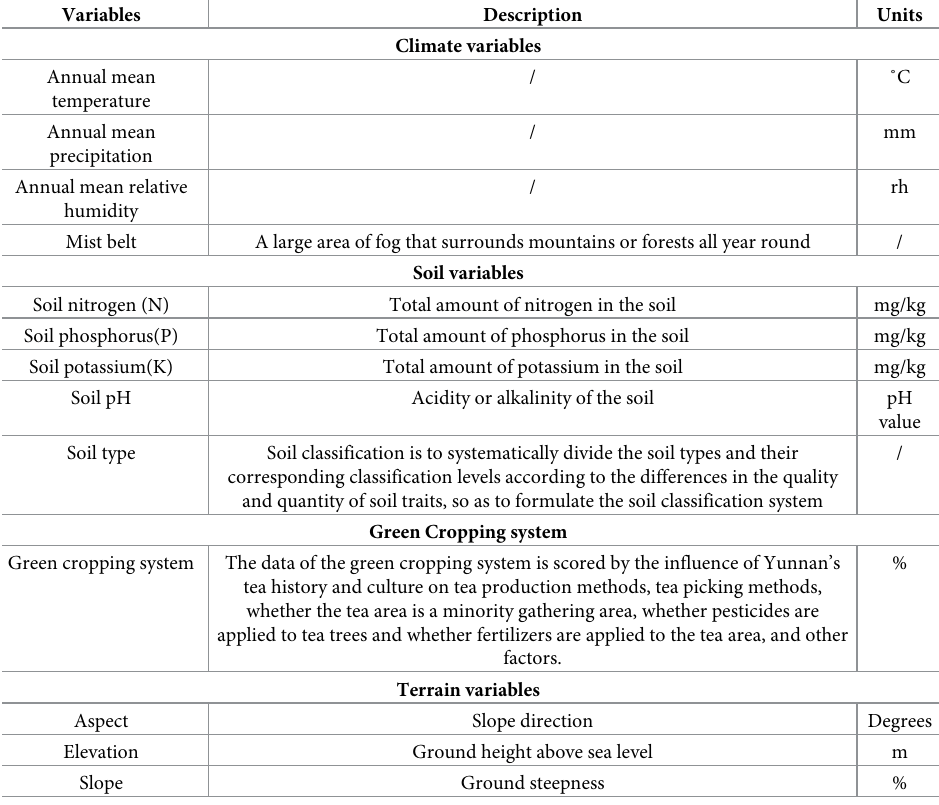
Table 1. Predictor variables in the evaluation of suitable areas for premium